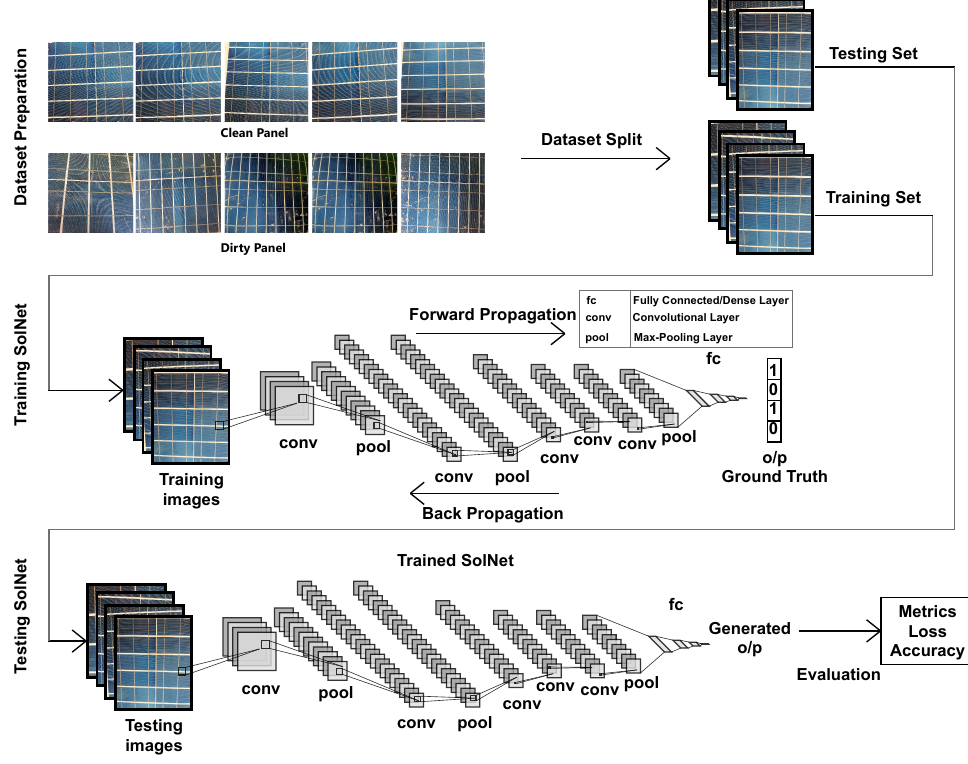
Figure 9. Workflow of proposed